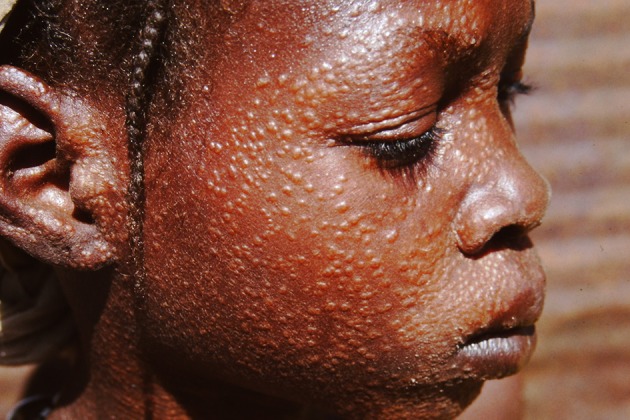
Typical papular rash in a patient from Sudan.